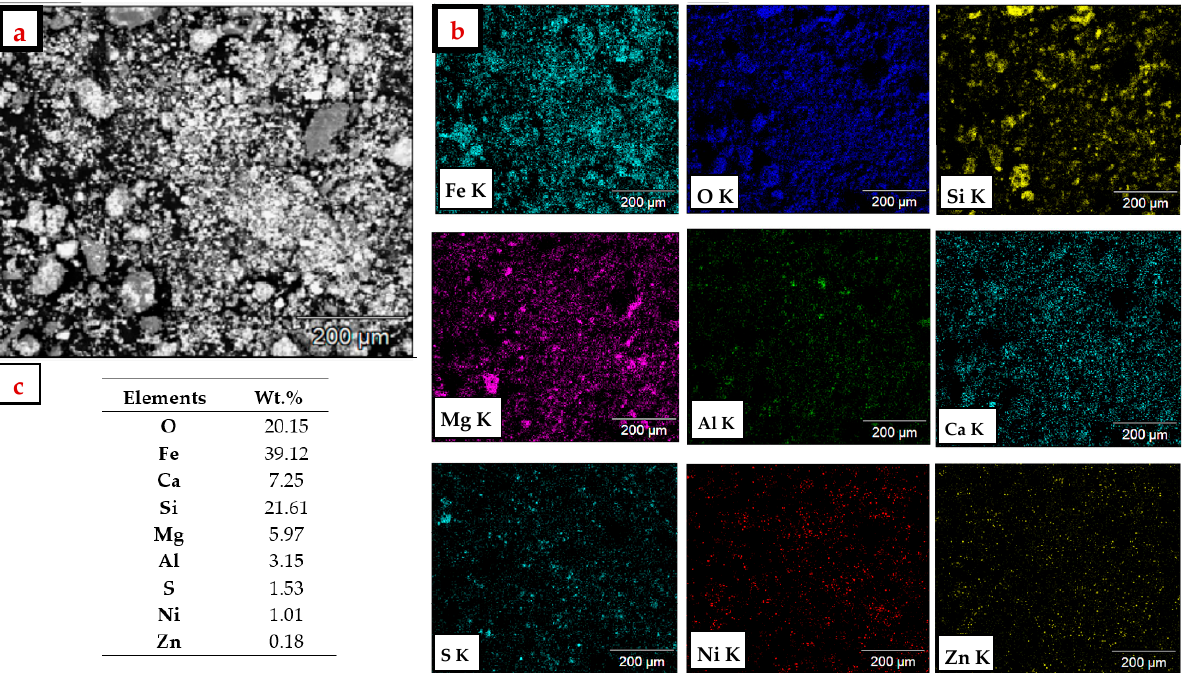
Figure 5. Backscattered electron image of SASR ( a ); distribution mapping of the different elements ( b ) and EDX element analysis ( c ).